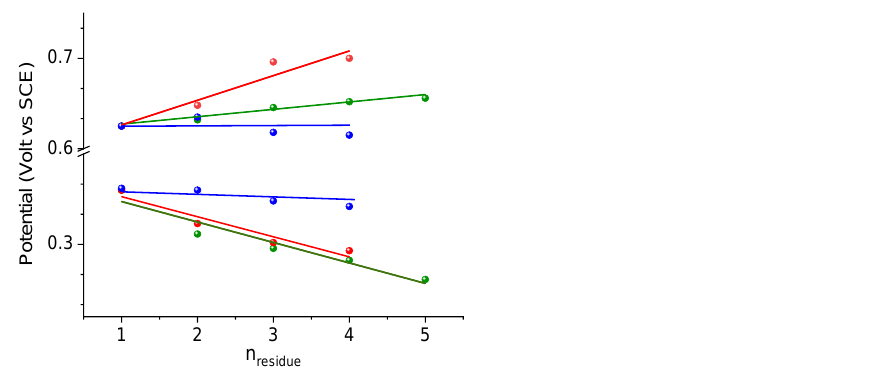
Figure 8. Comparison of variation in oxidation potential of L -Dap(Boc) (red), Aib (green) and ∆ Ala (blue) bis-ferrocenyl end-capped peptides. The data are normalized to the potentials of 1 .